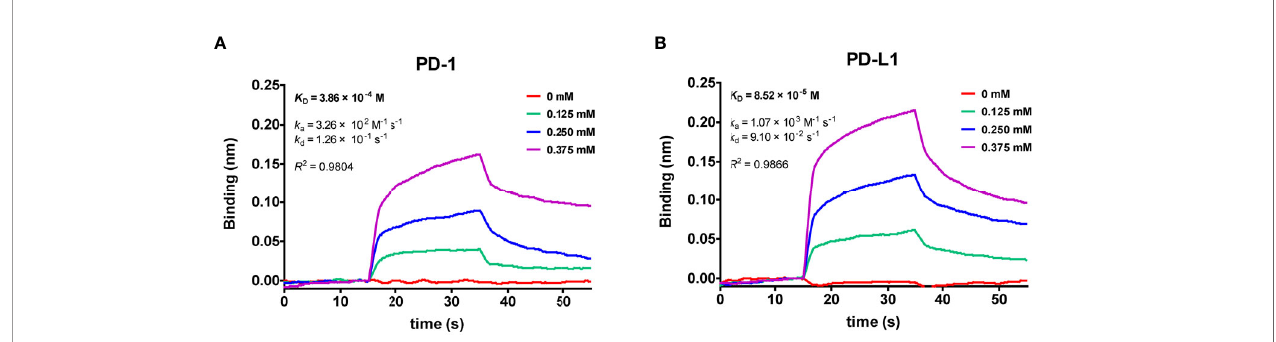
FIGURE 4 | Global kinetic analysis of cosmosiin binding to biotinylated (A) PD-1 and (B) PD-L1 immobilized on a streptavidin biolayer interferometry (BLI) sensor. The kinetics of cosmosiin for immobilized PD-1 and PD-L1 were monitored with increasing concentration of cosmosiin (0, 0.125, 0.25, and 0.375 mM), dissolved in PBS buffer (pH 7.3) containing